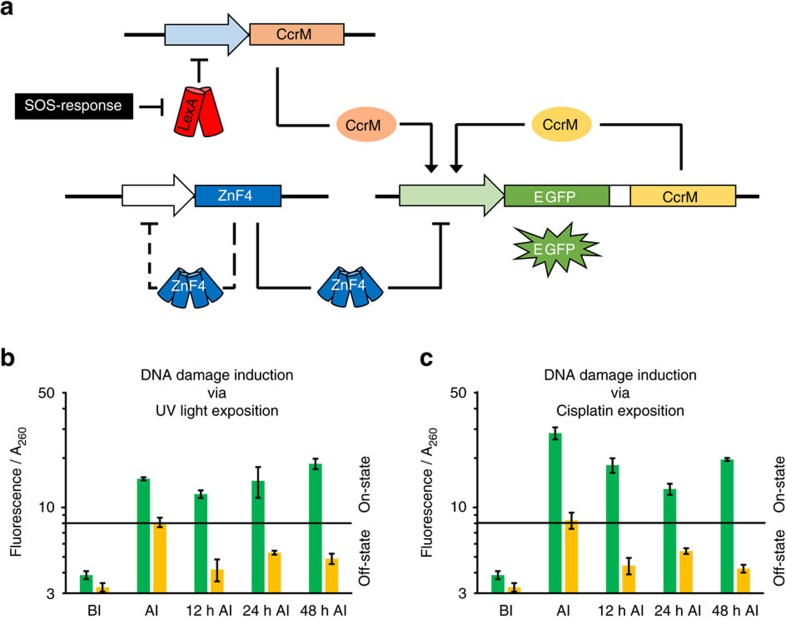
Induction of memory system III by DNA damage.(a) Circuit design of the DNA damage sensor with memory function. The trigger CcrM MTase is negatively regulated by the LexA repressor. On DNA damage, E. coli induces the SOS-response, which leads to cleavage of the LexA repressor and subsequently to the expression of the trigger MTase. (b) EGFP signal of ultraviolet-irradiated cells (3 × 50 J m−2 energy intake). The on-state signal is maintained by the reporter-maintenance operon for at least 48 h (error bars indicate s.d., n=2 biological repeats). (c) EGFP signal of cells treated with cisplatin. Cisplatin was removed from the medium after 12 h. Cells stayed in the on-state for at least 48 h (error bars indicate s.d., n=2 biological repeats). For a more detailed representation, see Supplementary Figs 17 and 18. For statistical analysis of the results shown in b,c, see Supplementary Table 3.